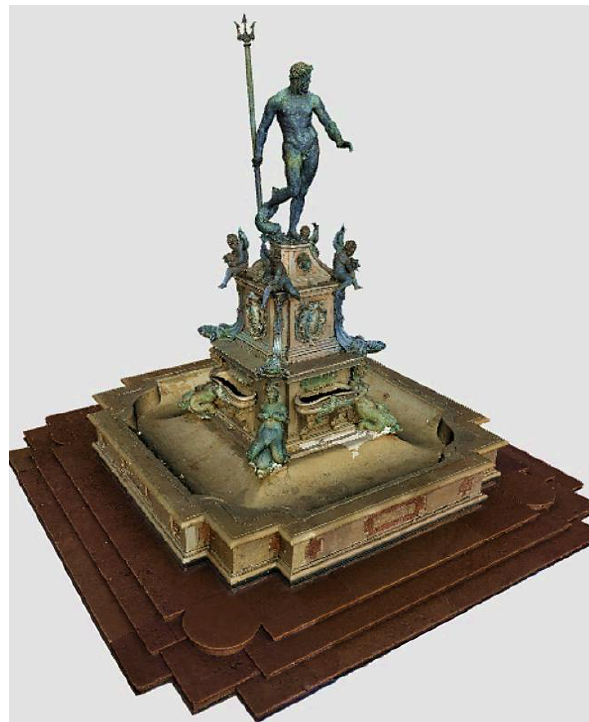
Figure 12. Overall image of the 3D model of the fountain as available in the information system.